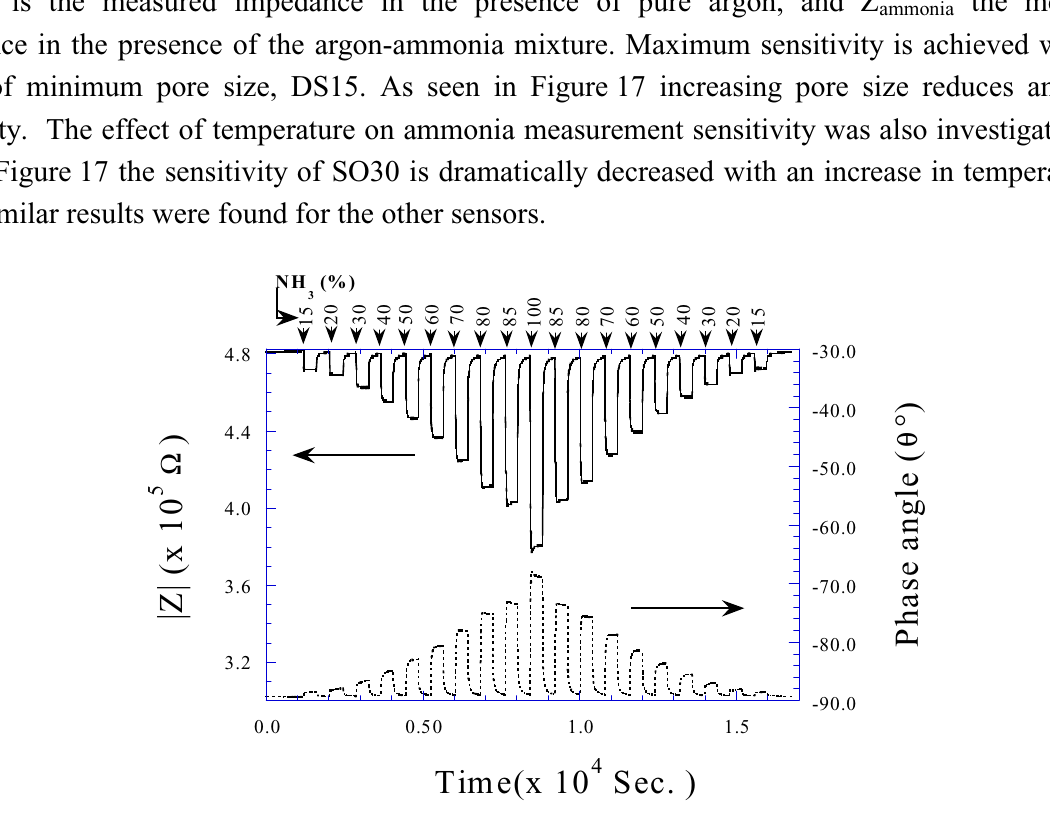
Figure 15. Change in impedance magnitude and phase of sensor SO30 in response to changing ammonia concentration. Argon is used as the carrier gas. The sensor response is completely reversible.